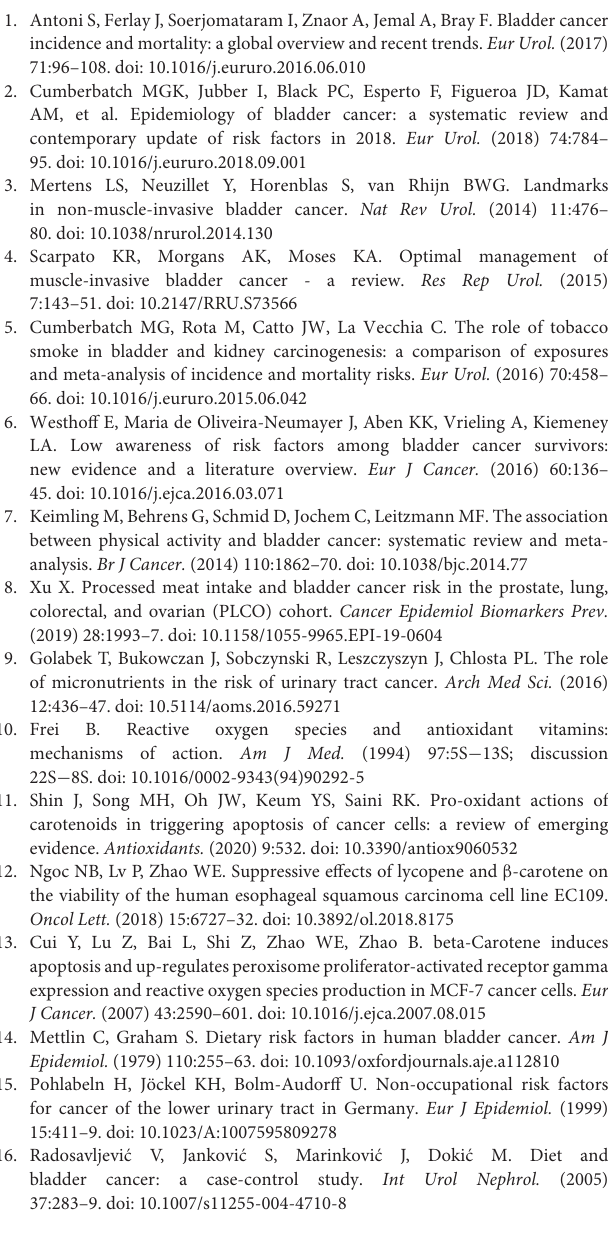
table study. Am J Epidemiol. (2001) 154:1089–99. doi: 10.1093/aje/154.12.